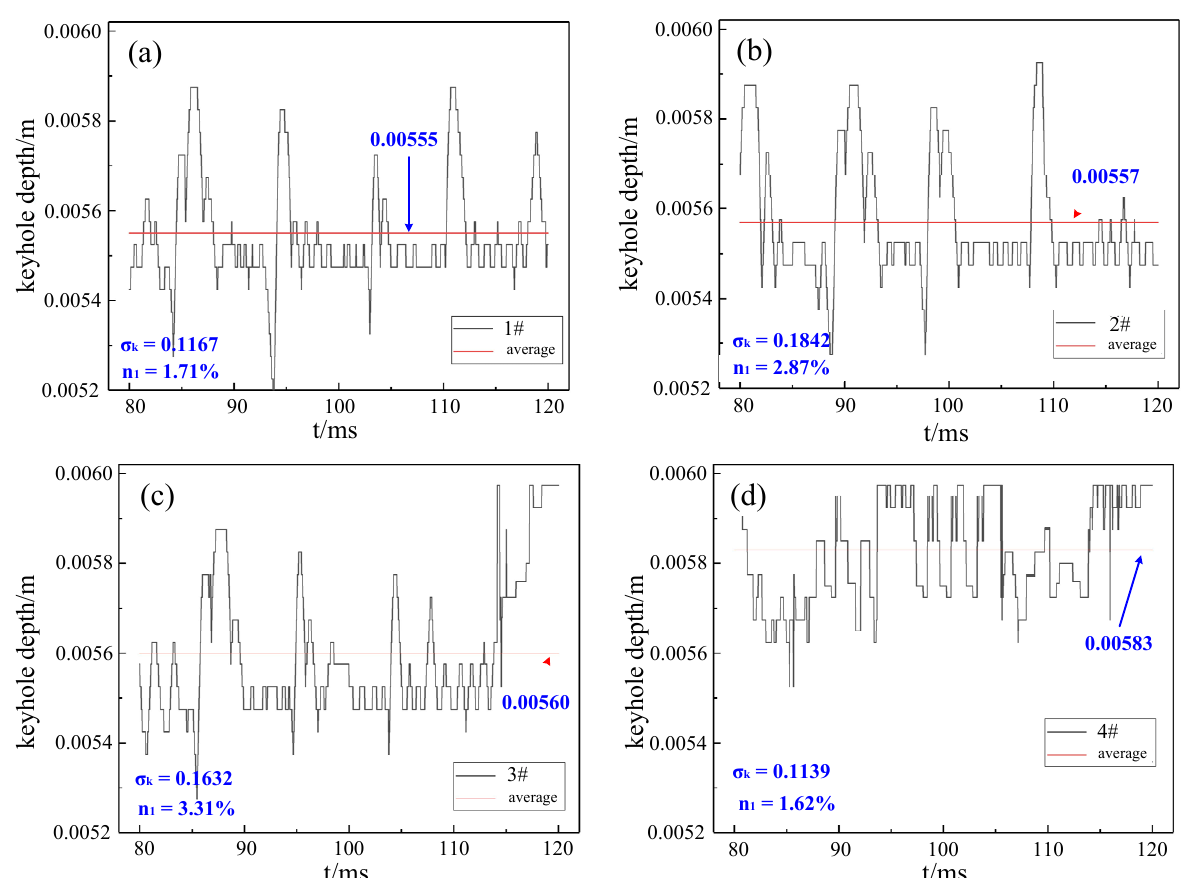
Figure 14. Variation diagram of keyhole depth in steady-state fluctuation stage. ( a ) P = 4.0 kW, I = 90 A, v = 1.5 m/min;